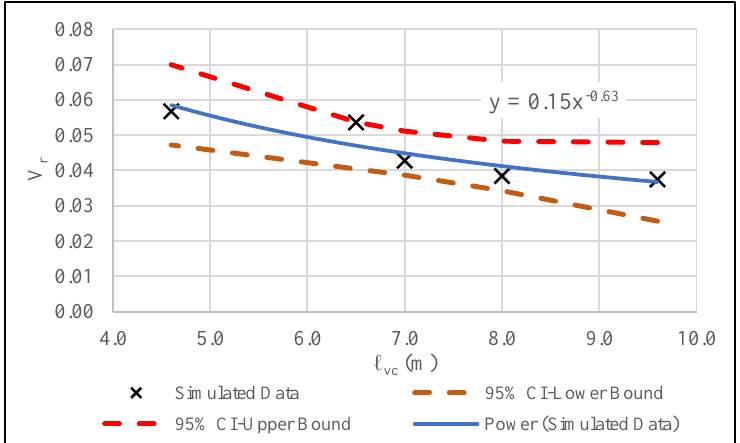
Figure 10. Relationship between V r against ℓ vc.